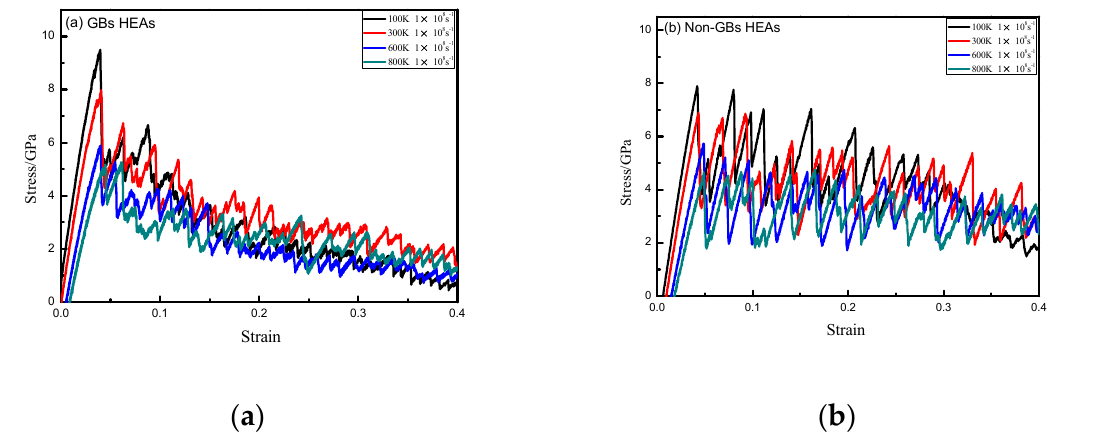
Figure 10. Stress-strain curves of deformation process at different temperatures of GBs HEAs and non-GBs HEAs; ( a ) GBs HEAs; ( b ) non-GBs HEAs. Tensile experiments with strain rates of 1 × 10 8 s − 1 at temperatures of 100, 300, 600, and 800 K process for Σ 3 GBs HEAs and non-GBs HEAs. The yield strength and Young’s modulus of both HEAs were obtained from Table 2. As the temperature increased, the yield strength and Young’s modulus of Σ 3 GBs HEAs were higher than those of non-GBs HEAs. In general, the higher the temperature, the higher the atomic thermal motion, which leads to an unstable structure and decreases the strength. In order to observe obviously the changes of lattice structure at different temperatures, the stacking faults at grain boundaries, and the nucleation and expansion of dislocations in the tensile deformation, the microstructure of atoms and dislocation lines under different strains were selected. Table 2. Young’s modulus and yield strength of GBs HEAs and non-GBs HEAs at different temperatures. Non-GBs Yield GBsyield Temperature/K Strength/GPa Strength/GPa